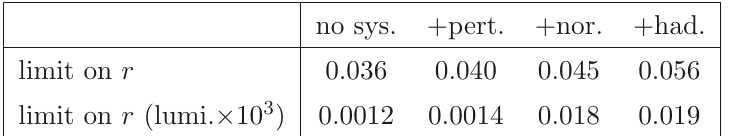
Table 3 . Impact of various systematic uncertainties on the expected 95% CL s exclusion limit of r with λ = 1 and a luminosity of 5 ab − 1 or 5000 ab − 1 . Numbers correspond to the exclusion limit without any systematic errors, and adding various systematic errors in